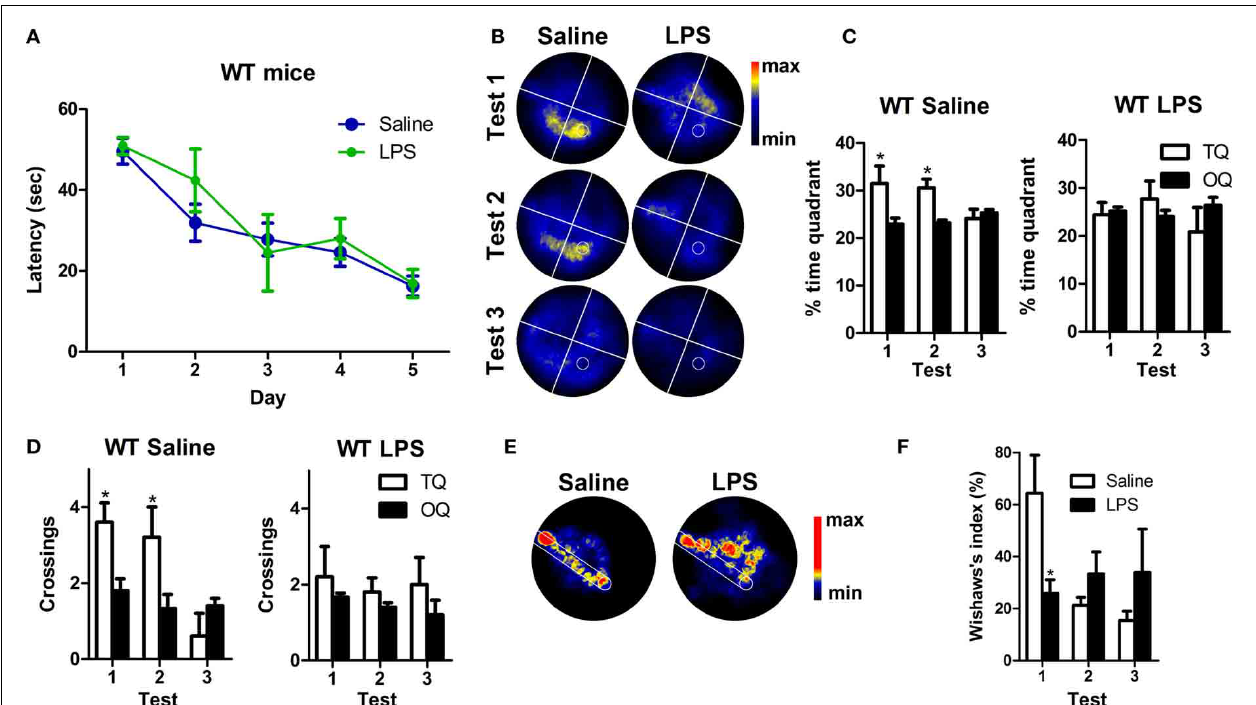
FIGURE 6 | LPS treatment induces mild impairment of spatial memory in WT mice. (A) The performance of saline ( n = 5) and LPS-treated WT ( n = 5) mice improved significantly along MWM training sessions. (B) Permanency plots showing the probability of mice location (maximum: red color, minimum: black). White lines divide quadrants and white circle indicates platform location. (C,D) Saline WT mice displayed significantly higher permanencies and crossings in the target quadrant (TQ) compared to the other quadrants (OQ) during the